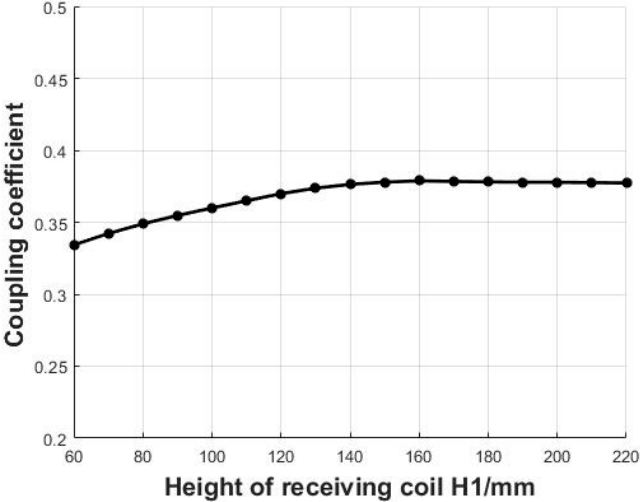
Figure 9. Simulation results of coupling coefficients at different H1.